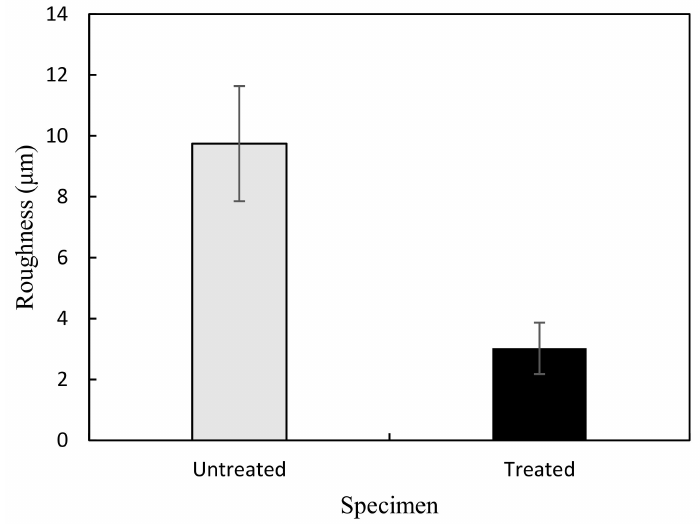
Figure 10. The average roughness of treated and untreated specimens measured by DektakXT.